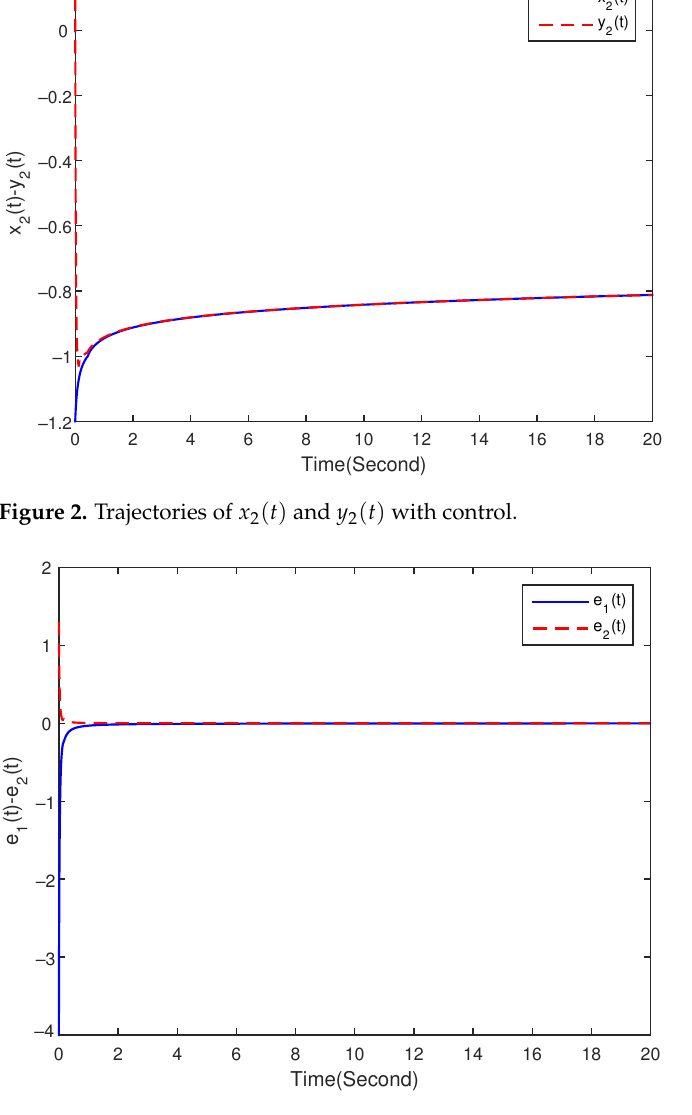
Figure 3. Trajectories of e 1 ( t ) and e 2 ( t ) with